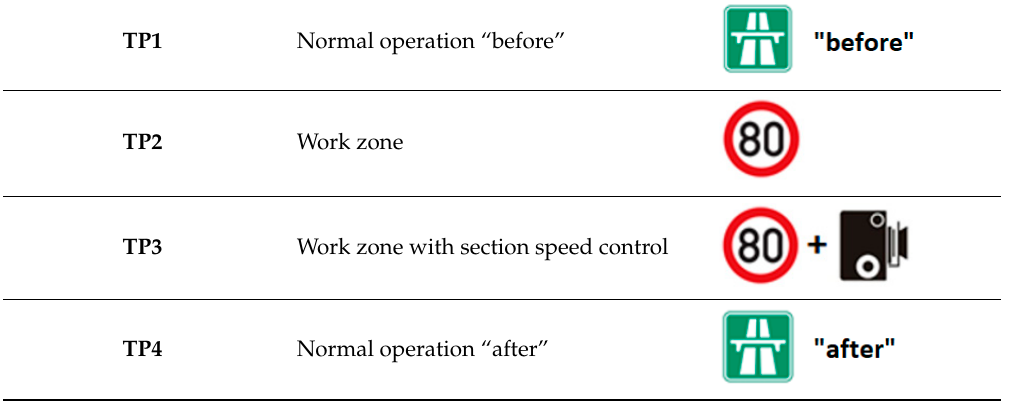
Normal operation “after”